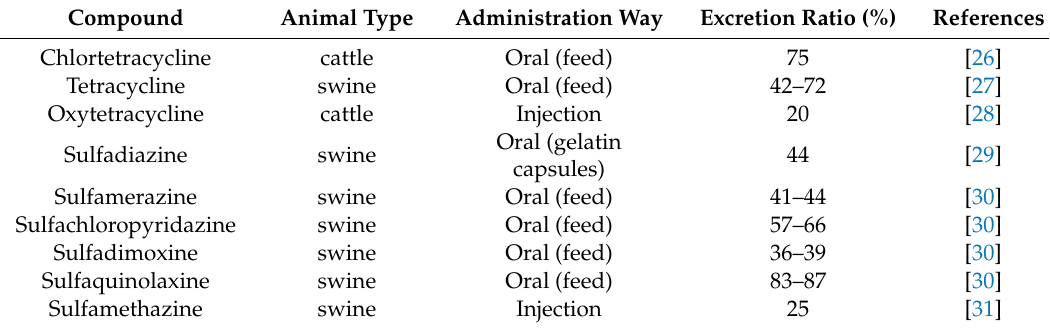
Table 4. Excretion rate (%) as uncharged form of di ff erent tetracycline and sulfonamide